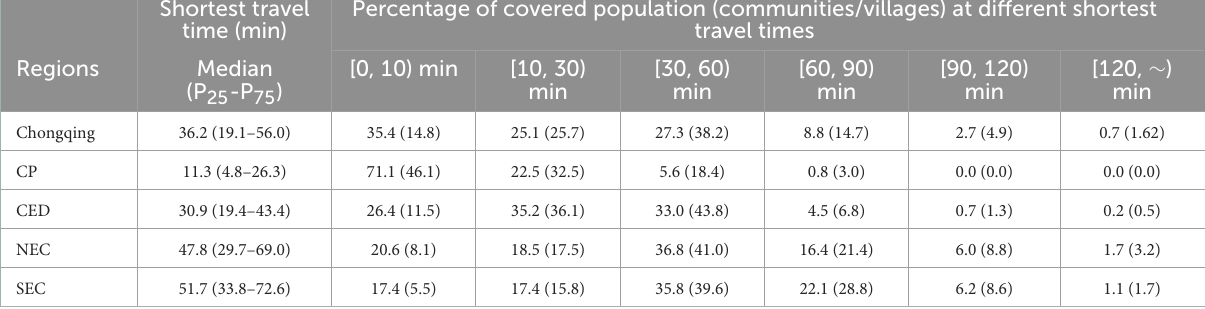
TABLE 5 Distribution of the shortest ravel time to get primary emergency medical services (EMS). Shortest travel Percentage of covered population (communities/villages) at different shortest time (min)